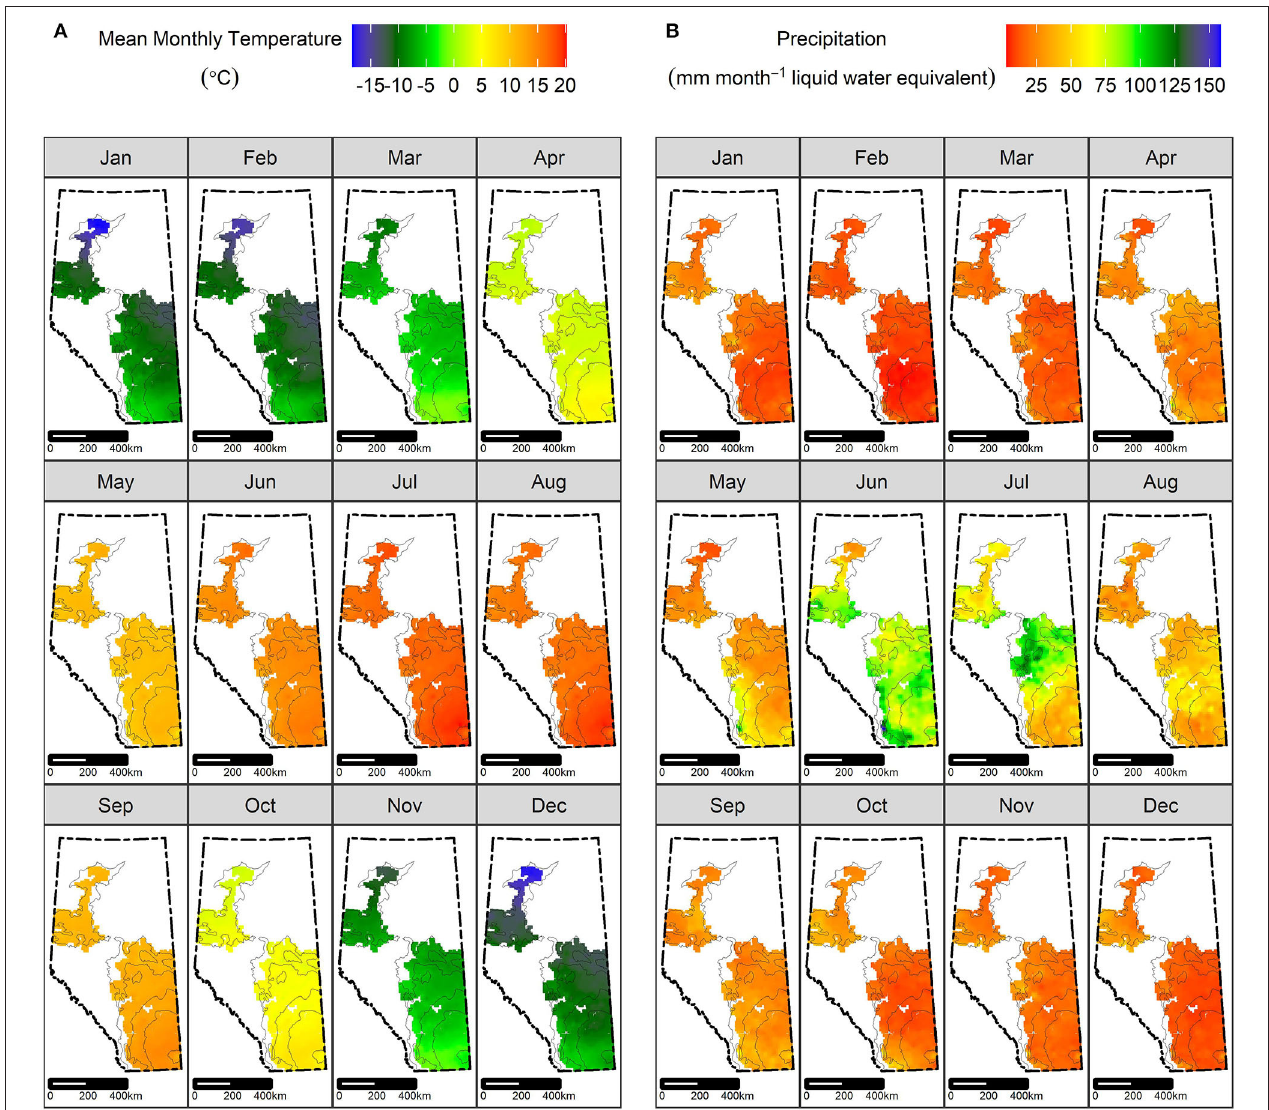
FIGURE 4 | Spatial distribution of (A) mean monthly temperature and (B) mean monthly precipitation across agricultural areas of Alberta averaged over the simulation period (January 1, 2011–December 31, 2015) (ACIS, 2019). The white areas on the map were not modeled based on the selection criteria as described in section Methodology and Model Inputs. The thick dashed lines on the maps represent Alberta’s provincial boundary and the thin black lines within the maps demarcate soil group areas.